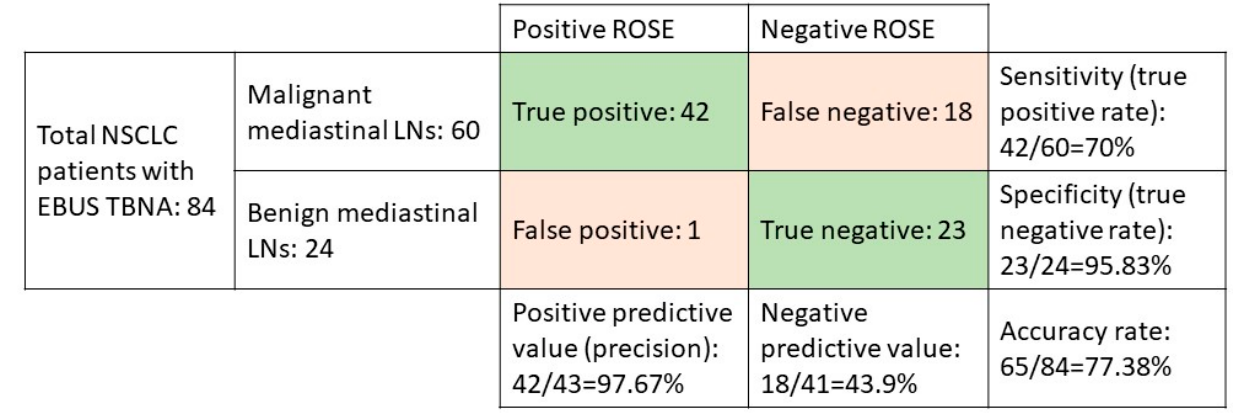
Figure 1. The confusion matrix of NSCLC patients who underwent EBUS-TBNA.